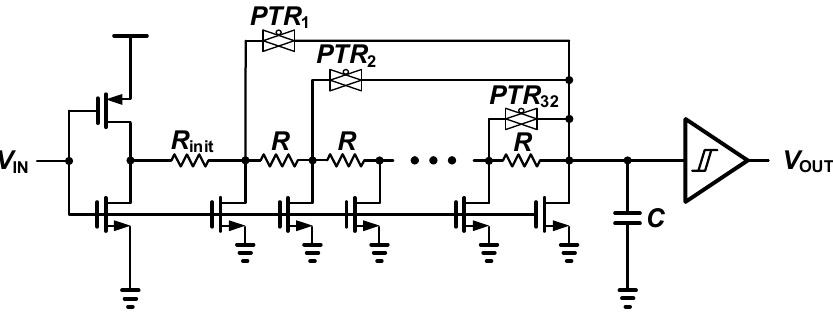
Figure 8. Proposed delay cell circuit including reset switch and Schmitt trigger.